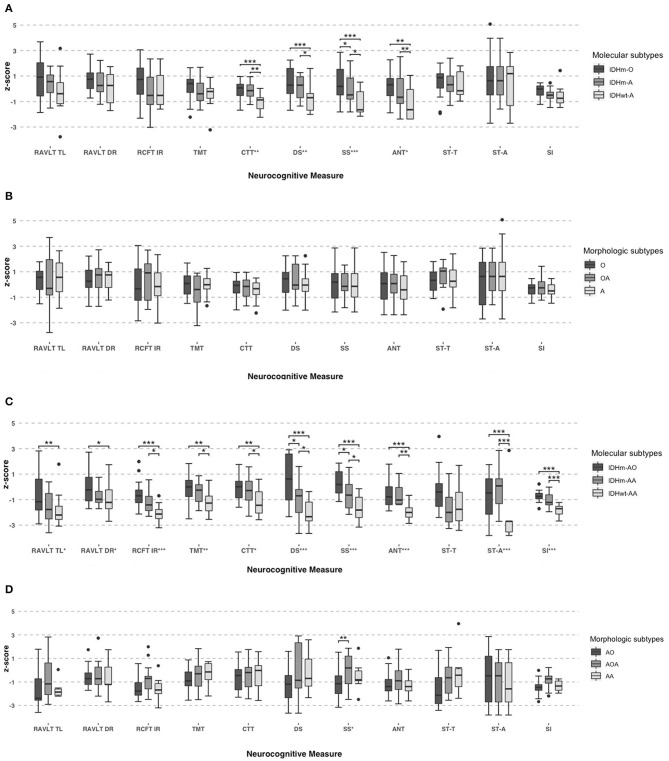
Neurocognitive performances in grade II subgroups based on molecular (IDH1 and 1p19q status) (A) and morphologic criteria (B). And neurocognitive performances in grade III subgroups based on molecular (IDH1 and 1p19q status) (C) and morphologic criteria (D). One-Way ANOVA tests and pairwise comparison used for group comparisons. *Significant, P < 0.05; **Significant, P < 0.01; ***Significant, P < 0.001.